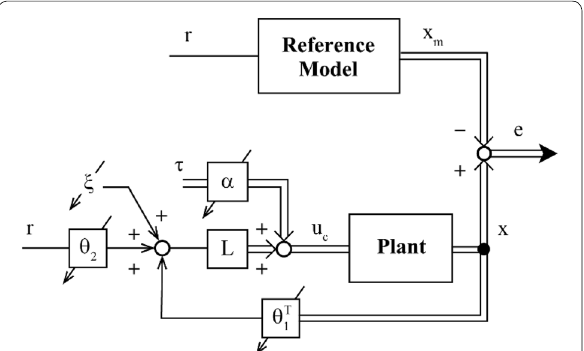
Fig. 5 Block diagram of the proposed fault-tolerant adaptive control